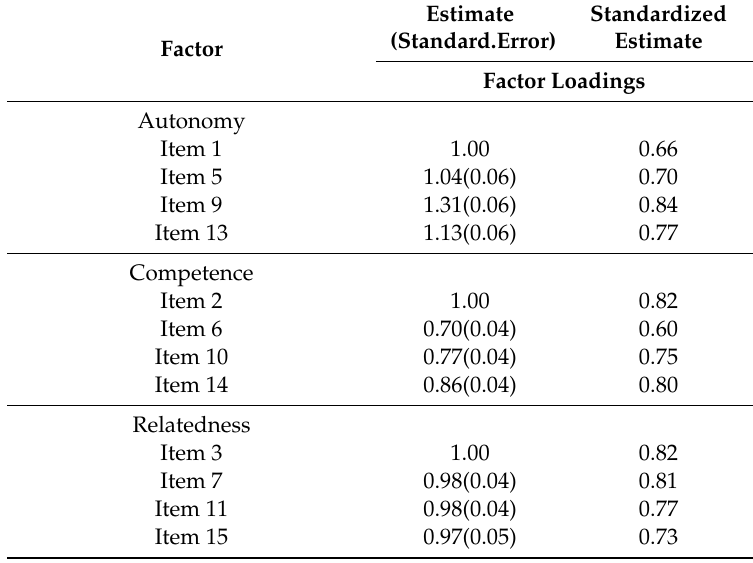
Table 1. Estimates of factor loadings and factor covariances for the four correlated factors model of the